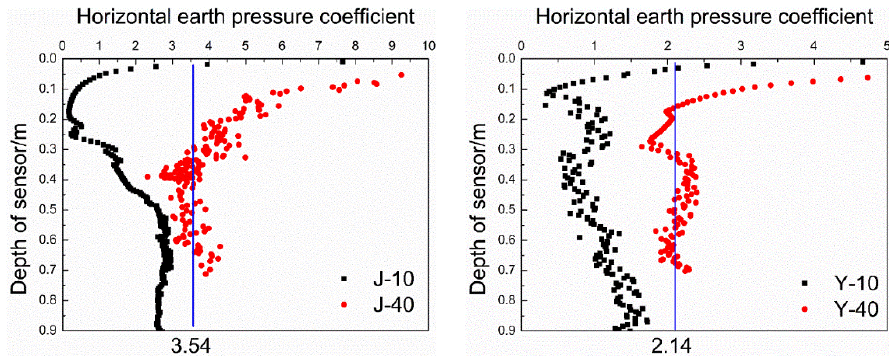
Figure 13. HB40 model. Note: J-10 and J-40 denote the soil-pressure sensor with different heights of 0.8 m from the side wall, and Y-10 and Y-40 denote the sensor on the other side of the model. The results show that the compaction effect on the horizontal-soil-pressure coefficient of the near-wall side of the models is greater than that of the far-wall side, and the horizontal-